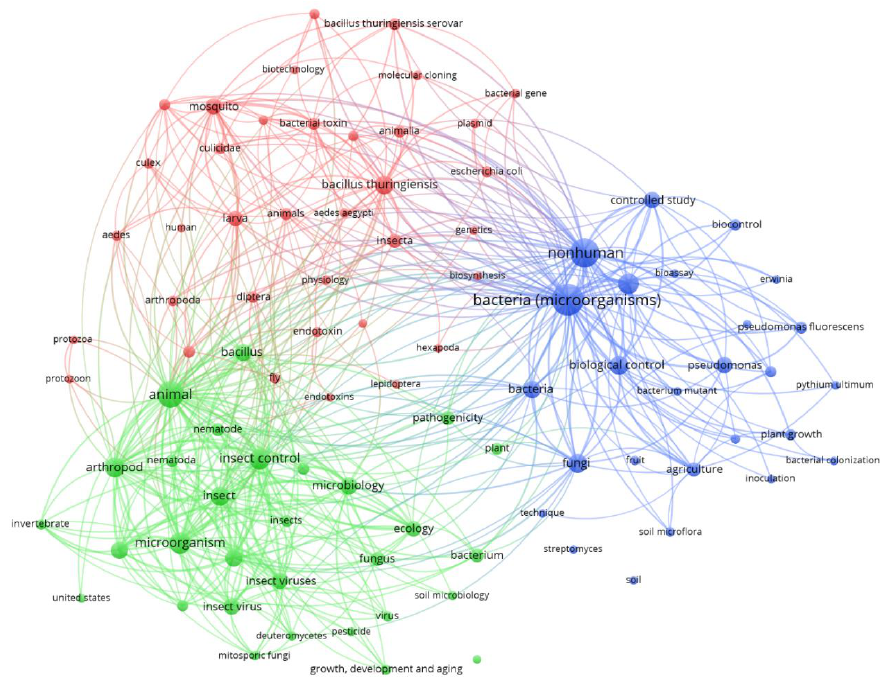
Figure 3. VOSviewer overlay visualization for “biological pest control” and “microorganism” from 1973 to 1997.